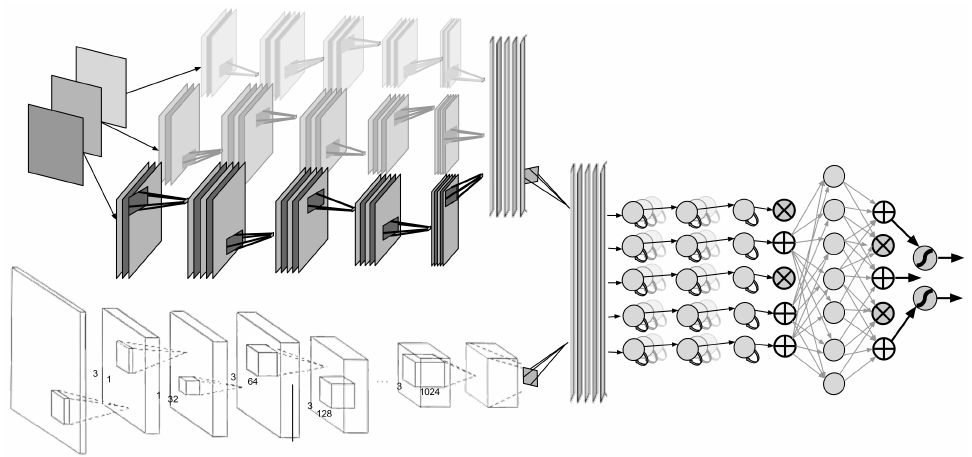
Figure 5. Self-driving operational